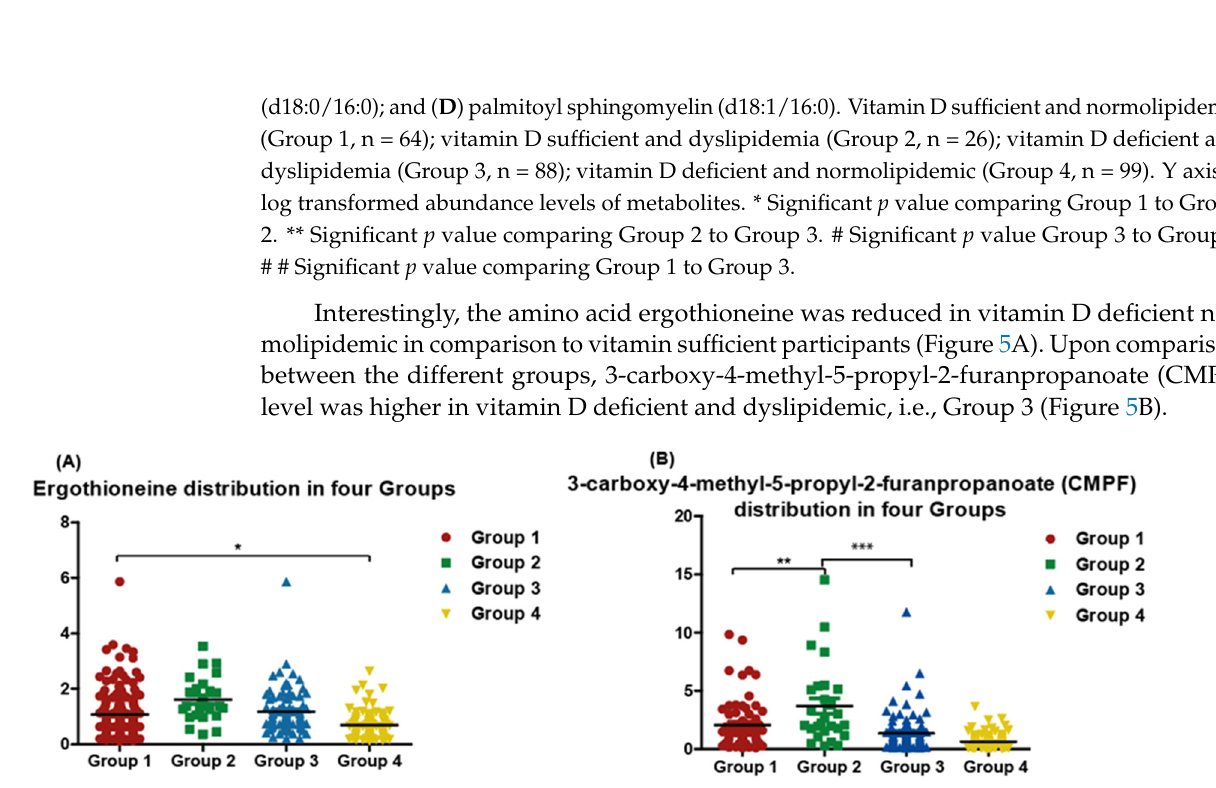
Figure 4. Metabolites quantity distribution among four groups of participants. ( A ) sphingomyelin